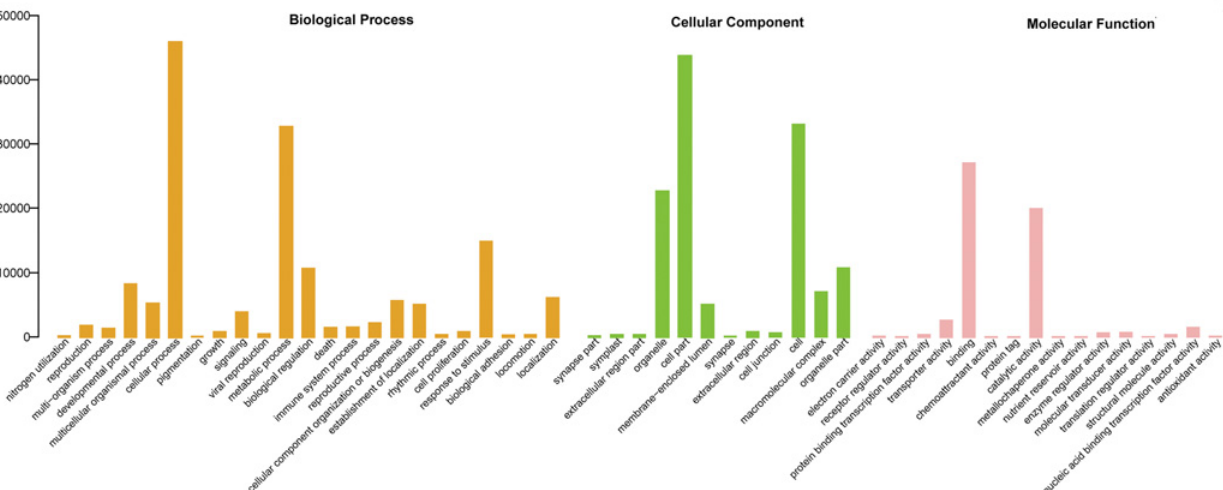
Fig 4. Gene Ontology (GO) classifications of assembled unigenes. 17,243 unigenes of S.sebiferm were assigned into the three main GO functional categories including biological process (45.61%), cellular component (38.107%) and molecular function (16.29%)